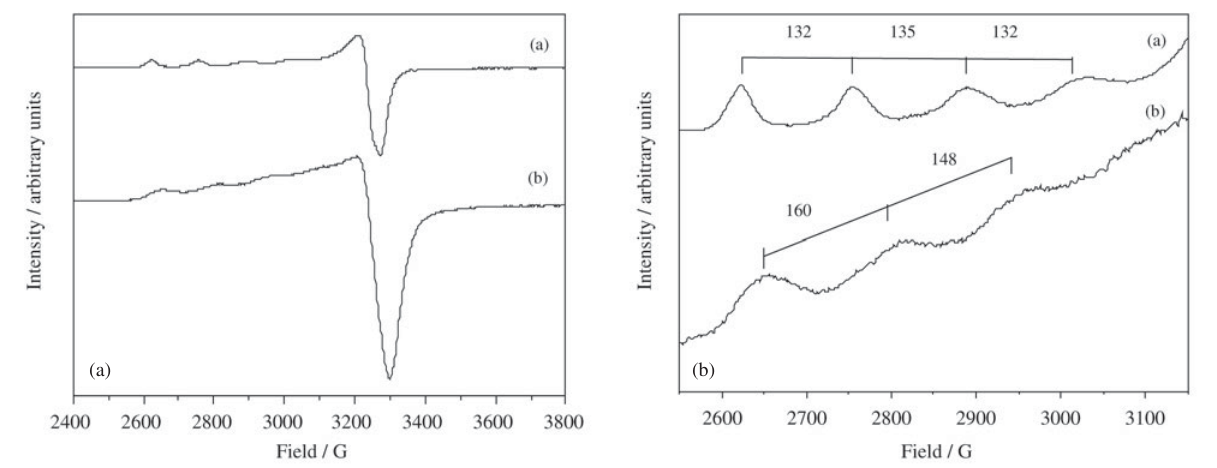
Figure 3. EPR spectra and copper hyperfine structure of: (a) Cu(0.8)Z(42) and (b) Cu(1.2)Z(11).